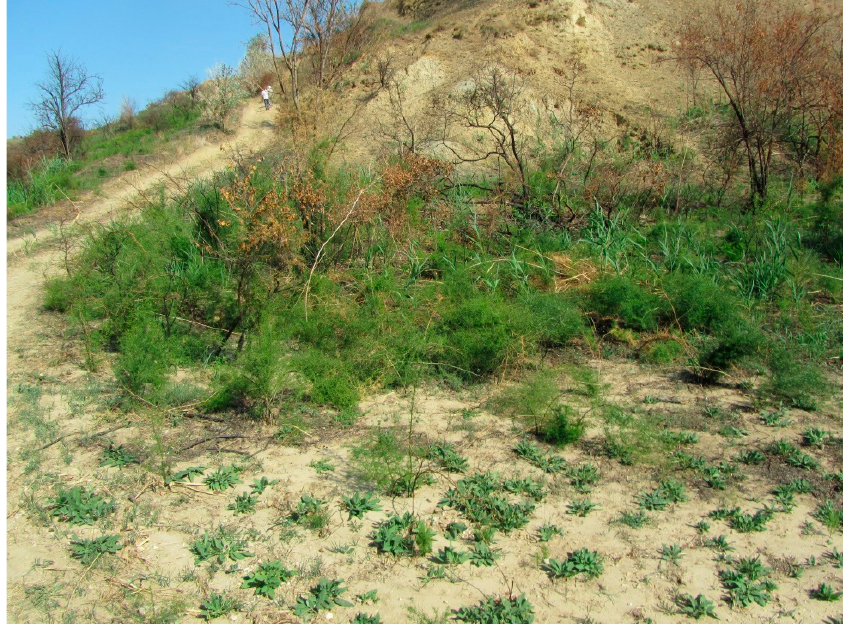
Figure 22. Restoration of Asparagus verticillatus in areas, that have undergone spontaneous burning out (surroundings of Novokubanka village).